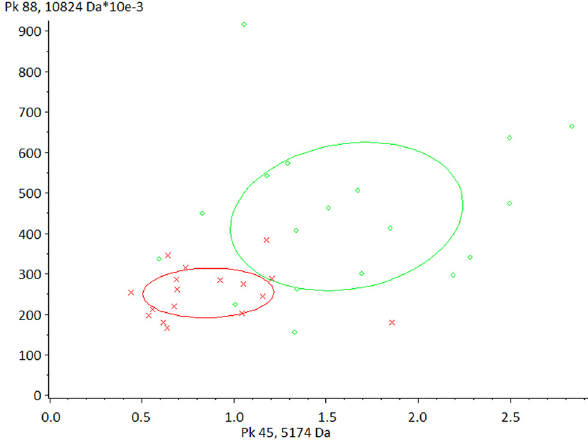
Figure 2: ClinProTools 2D peak distribution of polypeptide/protein with m / z 5174.2 ( x - axis ) and 10823.7 ( y - axis ) between healthy control subjects and TMD patients ( in red and green, respectively ) .